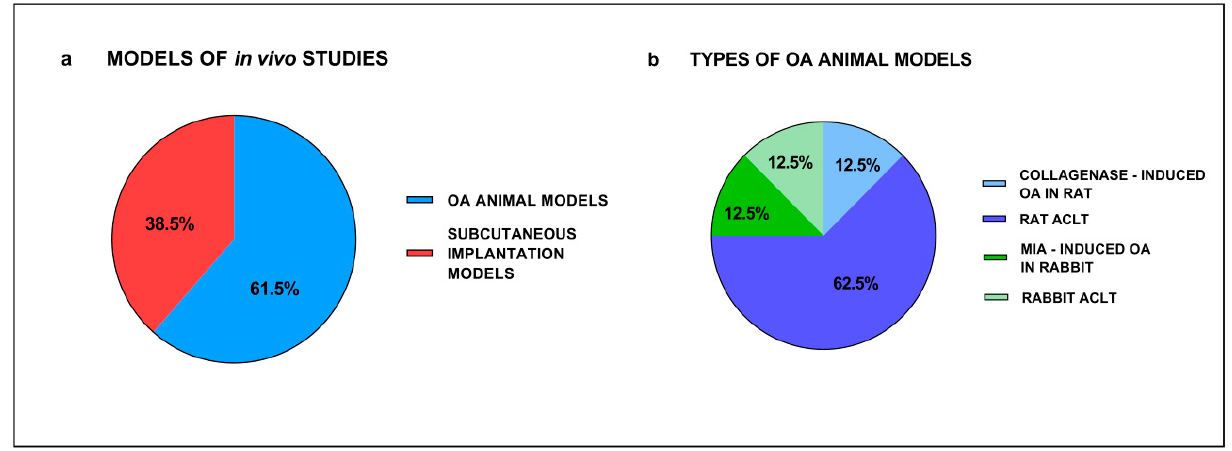
Figure 4. Types of in vivo studies ( a ) and types of OA animal models ( b ) in the selected articles. All studies performed a knee joint injection of embedded cells one, two or three times. In two out of nine rat OA model studies, human umbilical cord blood (hUCB)-MSCs or mixed human embryonic stem cells with MSCs were used. All studies evidenced from 4